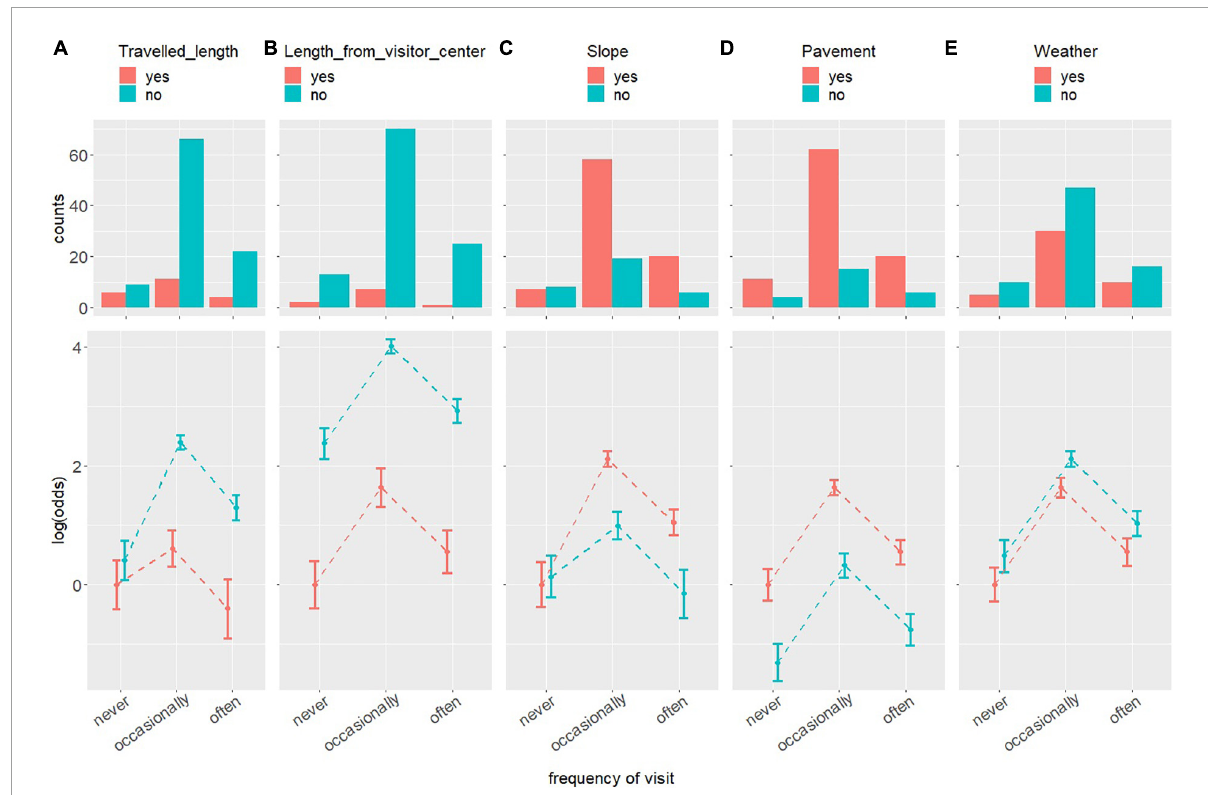
FIGURE2 Histograms and the logarithm of the odds resulting from applying a log-linear model in the cross-frequency tables of the relationships between the perception of, from left to the right, the distance traveled (A) , the distance from the visitor center (B) , the slope (C) , the type of pavement (D) , and the weather (E) as barriers for PwMDs to visit and enjoy natural sites and PwMDs’ visit frequency to these sites.